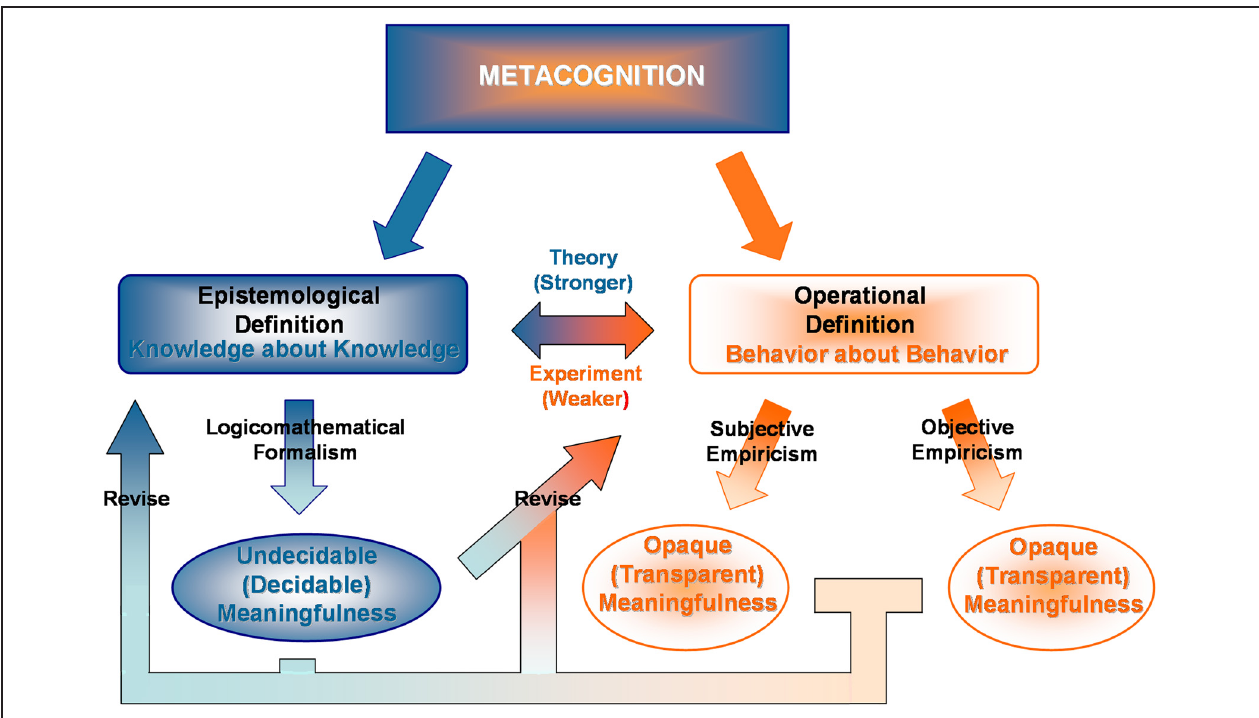
conclusion. Anti-mechanistic, -algorithmic, or -logic views of animal and human intelligence find varying degrees of support from noted thinkers in physics (Penrose, 1994), logic (Kreisel, 1967), philosophy, (Lucas, 1962) and psychology (Kahneman et al., 1982). Though a staunch anti-Intuitionist and pro-mathematical Platonist, Gödel (1951/1995) believed the human mind could overcome with empirical certainty such circumstances as “absolutely unsolvable Diophantine problems” and other undecidable problems suggestive of his